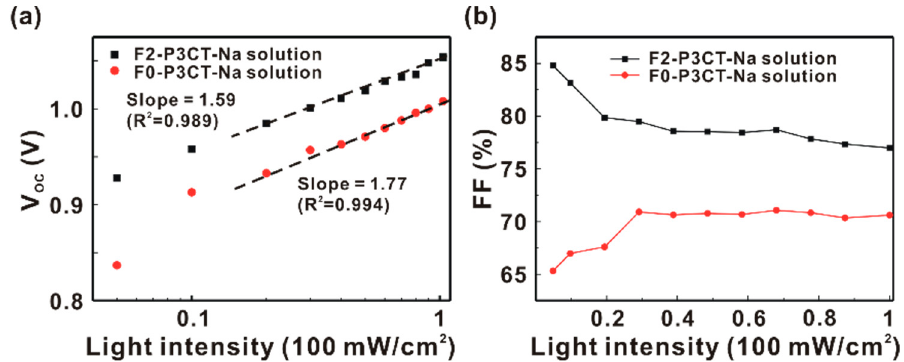
Figure 9. ( a ) Light-intensity dependent open-circuit voltage (V OC ) of the P3CT-Na based MAPbI 3 solar cells. ( b ) Light-intensity dependent fill factor (FF) of the P3CT-Na based MAPbI 3 solar cells.